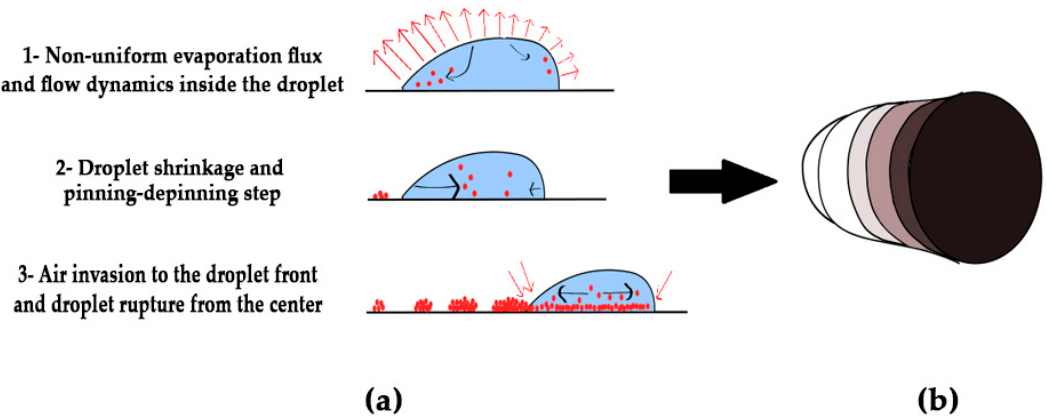
Figure 7. The schematic diagram of the drying process for concentrated dialyzed phage suspension, ( a ) the drying steps of droplet including: evaporation (formation of coffee rings and dense regions), and air invasion (formation of central area); and ( b ) final dried patterns. The colour gradient represents different nanoparticle densities deposited onto the substrate during the drying